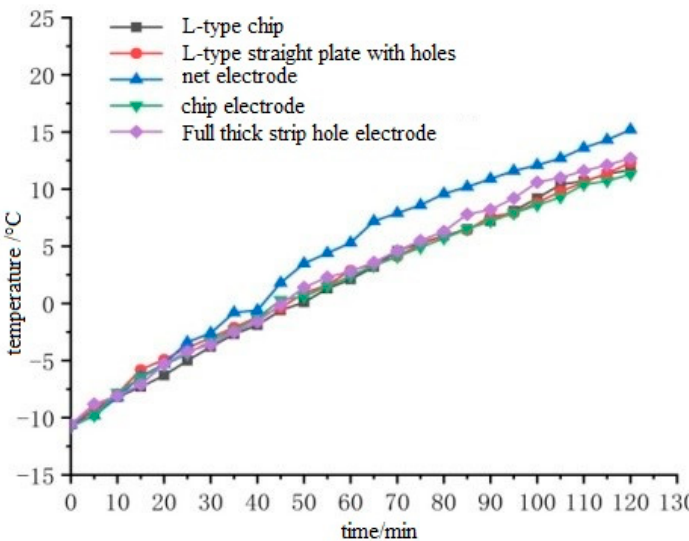
Figure 10. Comparison of the temperature rise of the upper surface of the buried electrodes on the left and right sides.